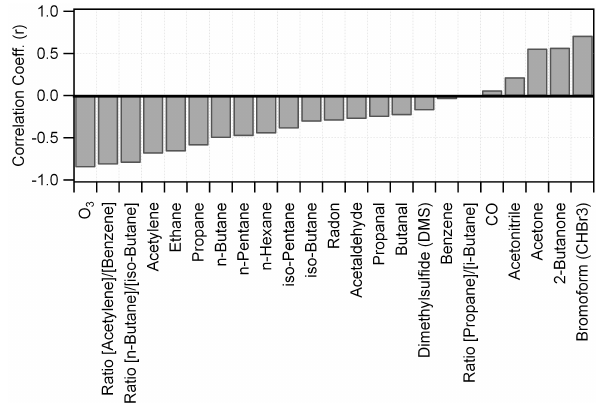
Fig. 7. Linear correlation coefficients for the 6-day cumulative modeled ICE exposure versus various gas-phase measurements made in the Arctic during